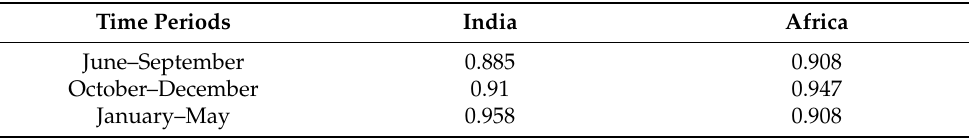
Table 3. AUC values of the Maxent model’s performance. Time